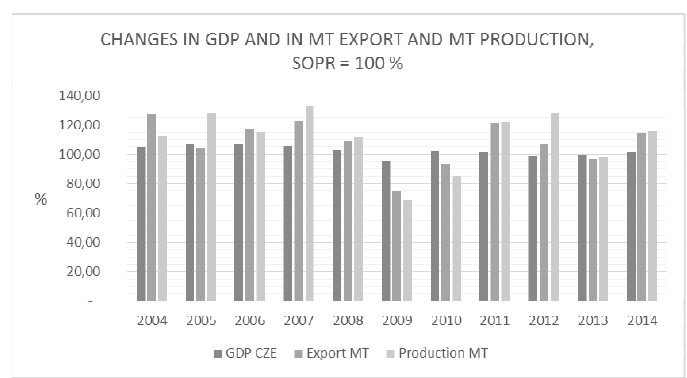
Fig. 7 - Annual changes in the country’s GDP and exports and production of machine tools in the Czech Republic from 2004 to 2014, constant prices. Source: CZSO, (2017) . Association of Engineering Technology: Reports on the state of Machine Tools Branch in the Czech Republic 2007 - 2014.